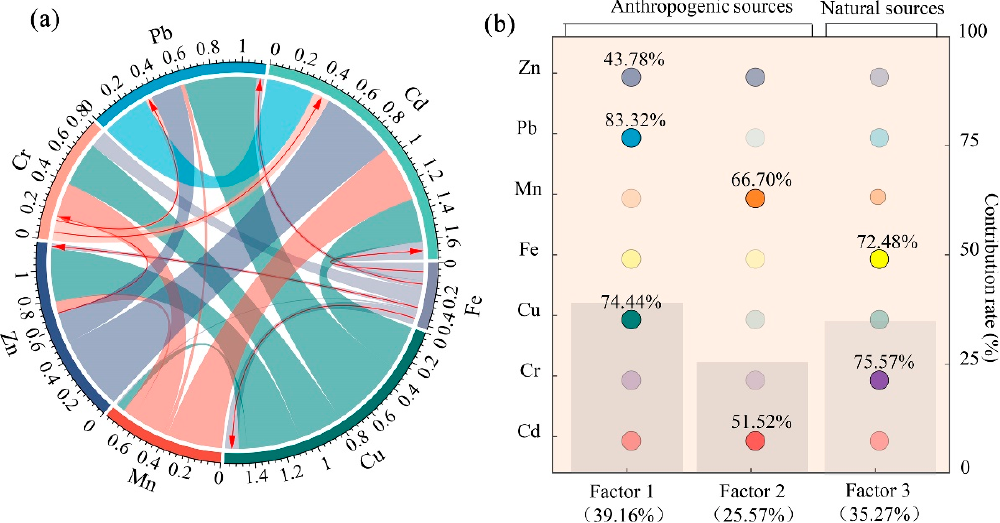
Figure 3. Source analysis of heavy metals in groundwater by combing ( a ) Pearson correlation analysis and ( b ) absolute principal component scores/multiple linear regression (APCS/MLR). (The width of each heavy metal is shown to denote the correlation coefficient. The red arrow denotes a negative correlation between two heavy metals. The histogram is used to represent the percentage of each factor. Different color gradients are used to indicate the proportions of each heavy metal to the different factors.)